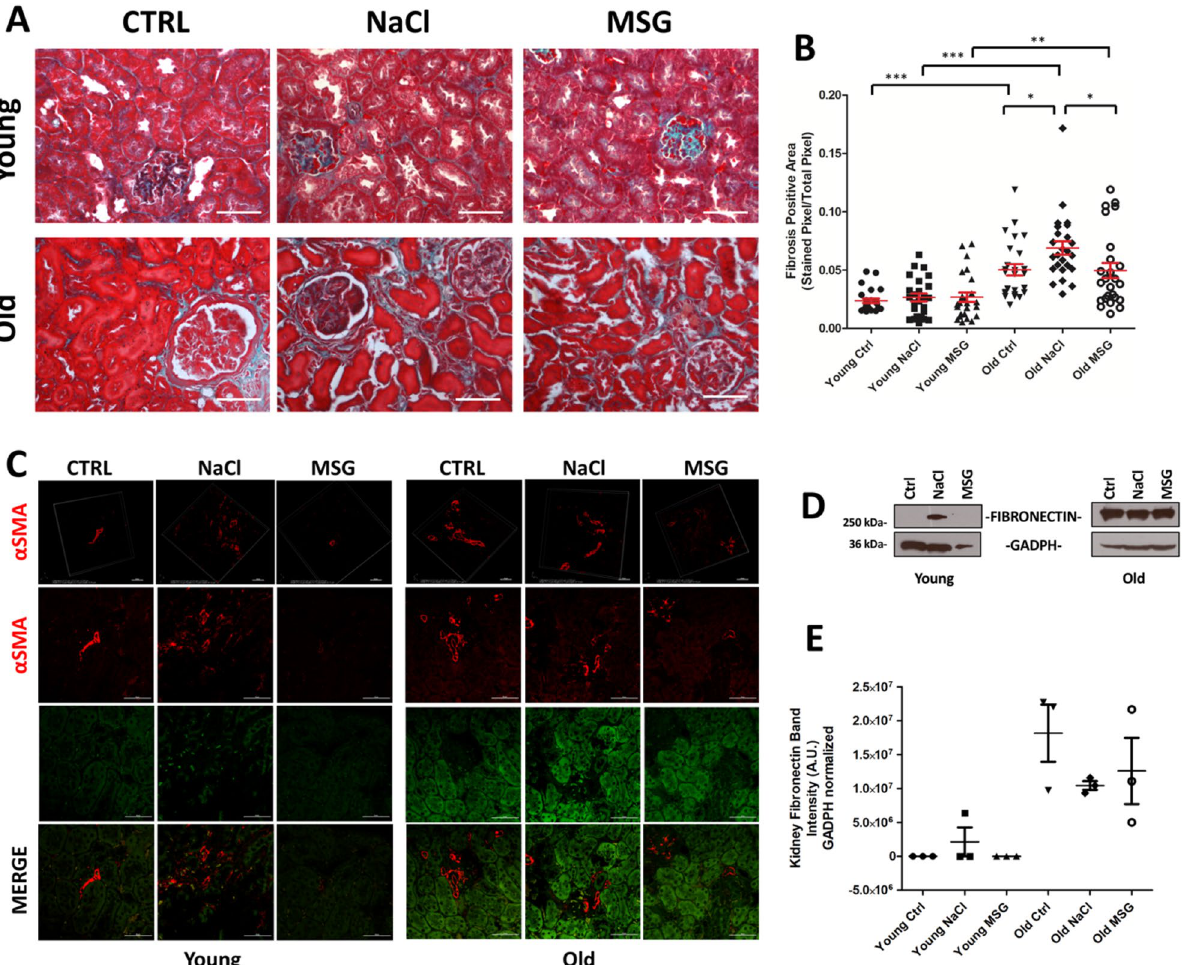
Figure 4. Evidence of kidney fibrosis evaluated with histology staining, αSMA labelling and fibronectin deposition. ( A ) Representative Gomori trichrome renal staining (× 40). ( B ) The dot plot analysed the fibrosis intensity in function of age and treatment (n = 25 sections from 5 mice in each group, t test * p < 0.05, ** p < 0.01). ( C ) Immunofluorescence showing the presence of αSMA in the kidney. The green channel, unmarked, display the background and shows the morphology of the tissue. Scale bar, 50 µm. The panels in the first row represent the 3D reconstruction of the bidimensional images (scale bar 20 µm). ( D ) Fibronectin deposition in the kidney, a representative Western blot is shown. ( E ) Analysis of fibronectin deposition, as a proportion of fibronectin normalized to GAPDH ( A.U. arbitrary units, n = 3/group). No fibronectin was detected in young control and MSG